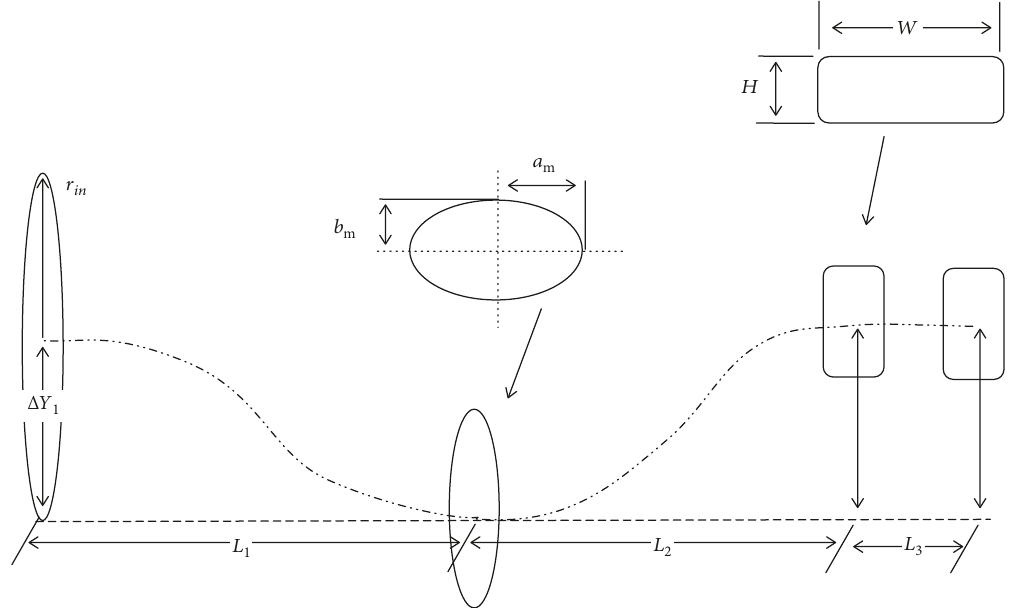
Figure 1: Design parameters of the double S-shaped nozzle.